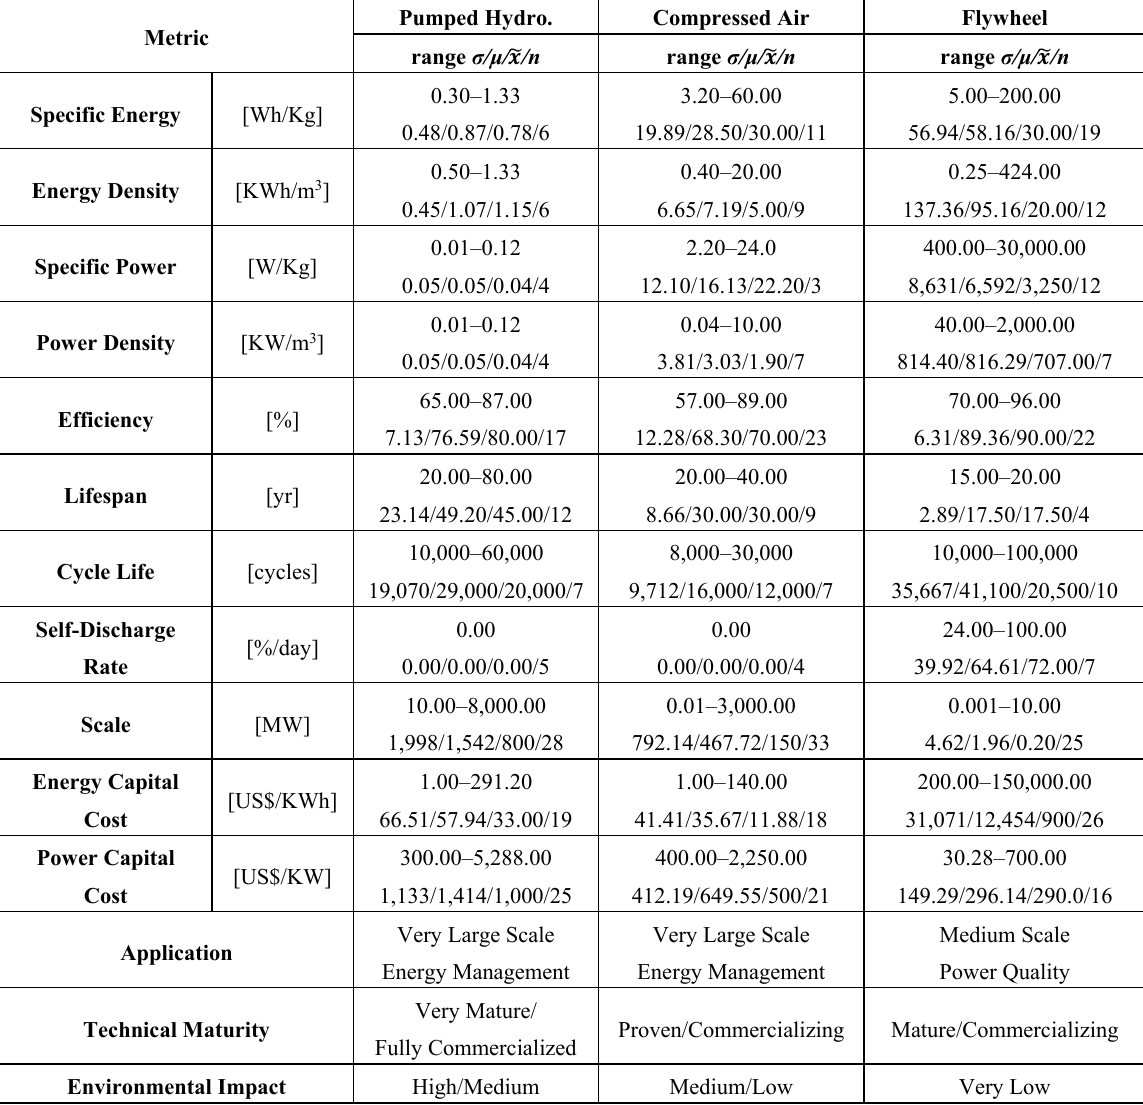
Table 3. Comparing mechanical storage based on fourteen different metrics. Data obtained or calculated from multiple sources